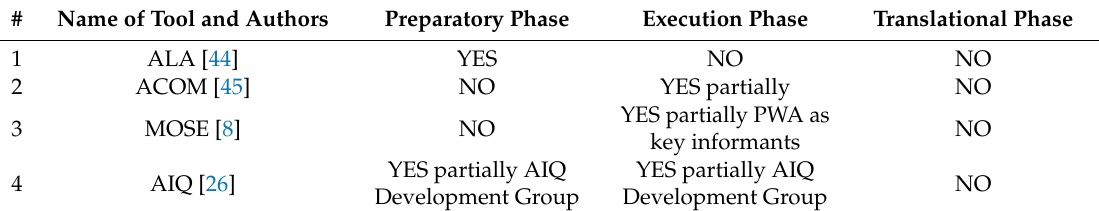
Table 5. Summary of the phases and stages of the involvement of PWA based on the Patient and Service User Engagement (PSUE) framework